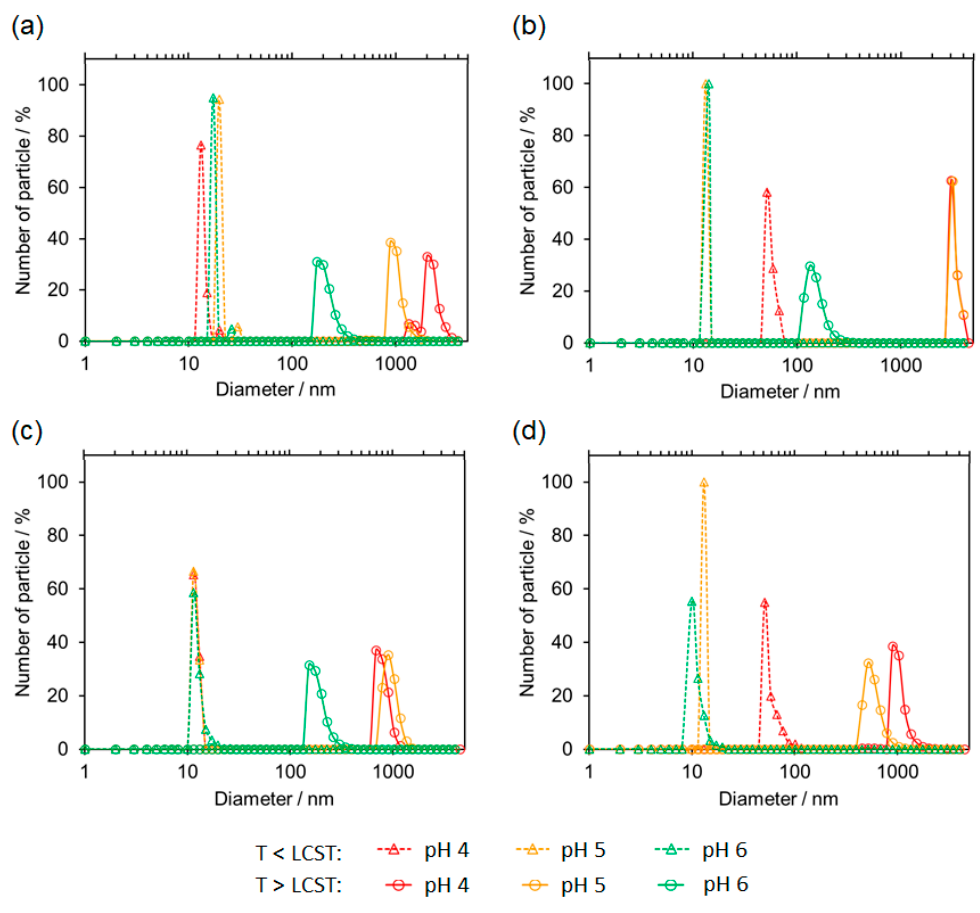
Figure 4. Dynamic light scattering (DLS) analyses of ( a ) P1 , ( b ) P2 , ( c ) P3 , and ( d ) P4 in different pH aqueous media. Here, red represents pH 4, yellow is pH 5, and green is pH 6. The triangles and broken lines represent below the LCST ( P1 : pH 4, 20 °C; pH 5, 20 °C; and pH 6, 25 °C. P2 : pH 4, 20 °C; pH 5, 20 °C; and pH 6, 25 °C. P3 : pH 4, 25 °C; pH 5, 25 °C; and pH 6, 25 °C. P4 : pH 4, 25 °C; pH 5, 25 °C; and pH 6, 25 °C). The circles and solid lines represent above the LCST ( P1 : pH 4, 32 °C; pH 5, 32 °C; and pH 6, 38 °C. P2 : pH 4, 32 °C; pH 5, 35 °C; and pH 6, 44 °C. P3 : pH 4, 44 °C; pH 5, 44 °C; and pH 6, 53 °C. P4 : pH 4, 50 °C and pH 5, 56 °C).